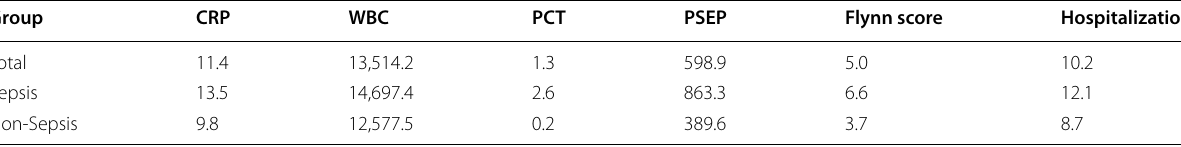
Table 3 Mean values of diagnostic lab tests